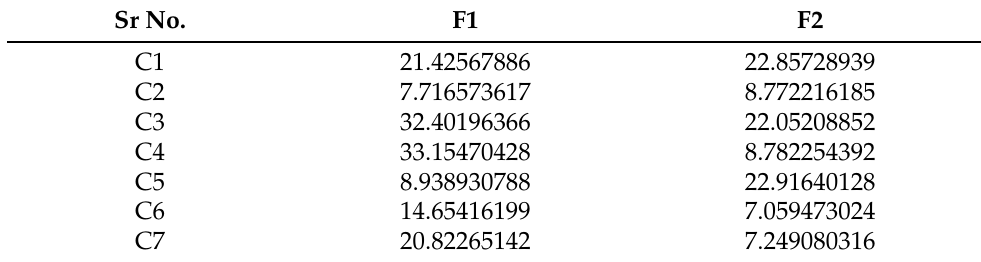
Table 14. The best centroids for Aggregation obtained by proposed approach.